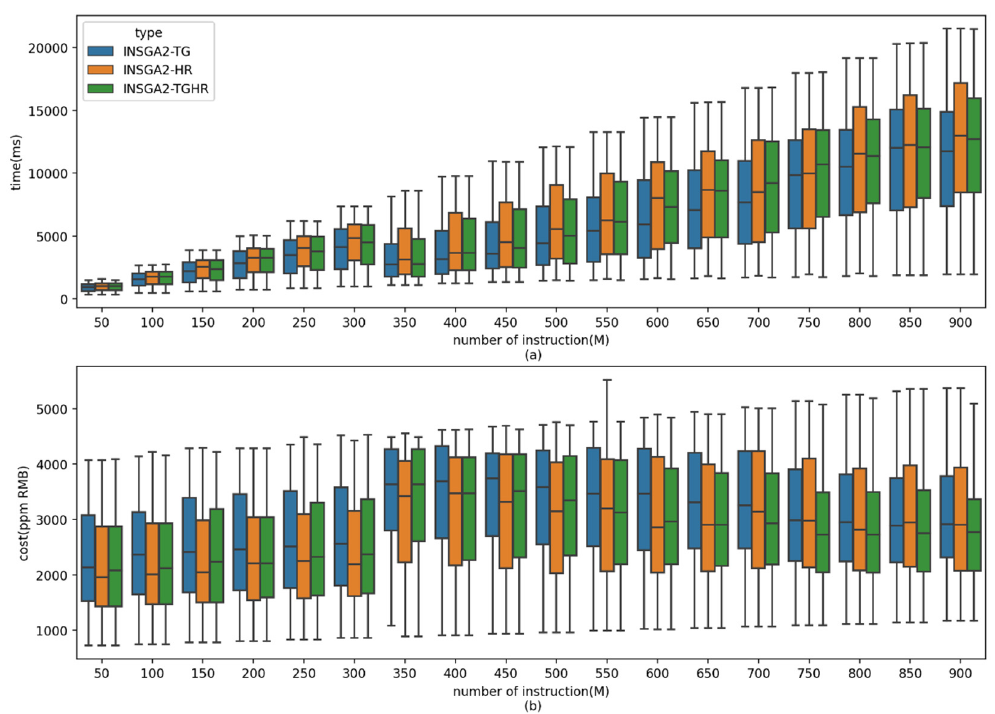
Figure 16. The boxplot in different number of task instructions. ( a ) Comparing the effect of number of task instructions on time; ( b ) Comparing the effect of number of task instructions on cost.